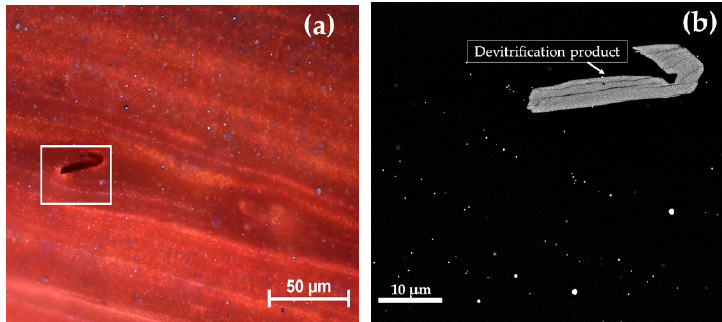
Figure 15. Gr-3 group sample: R22 at optical micrograph ( a ) and FEG–SEM micrographs of R22 ( b ).